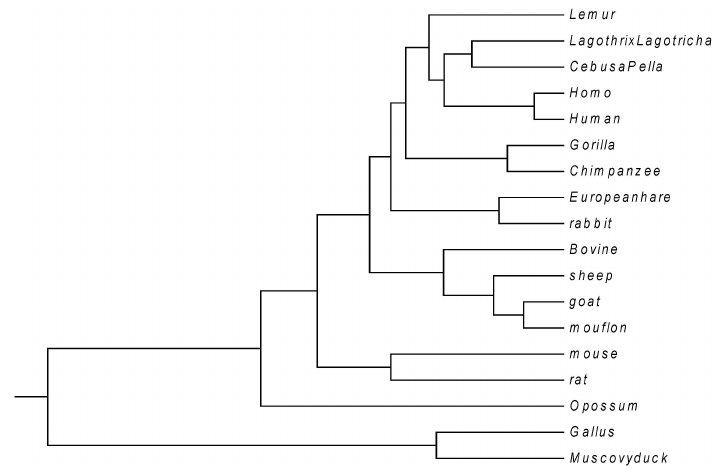
Figure 3. The relationship tree of 18 species.